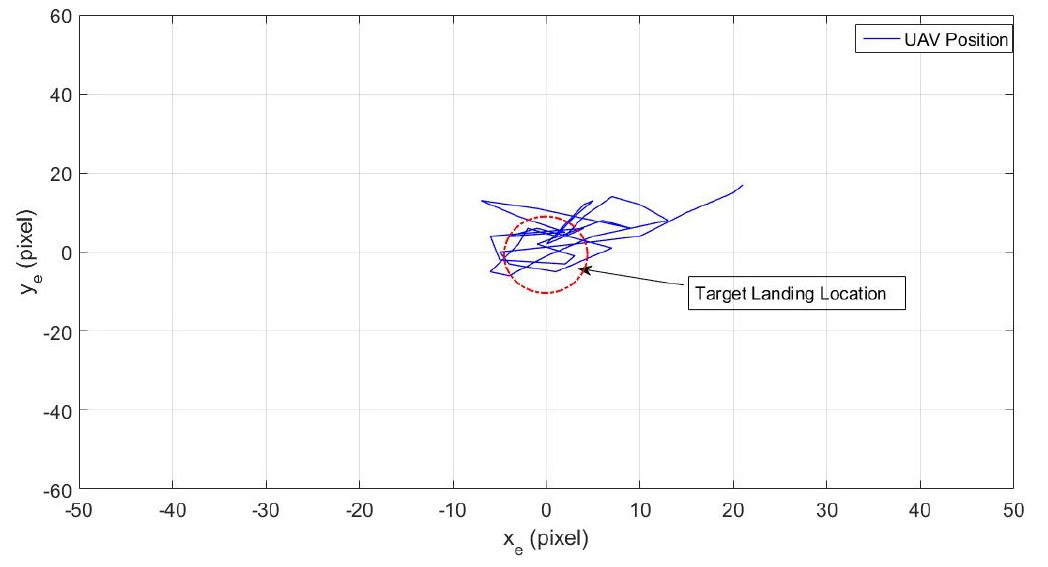
Figure 11. AR.Drone hovering and maintaining the center position over the detected target.